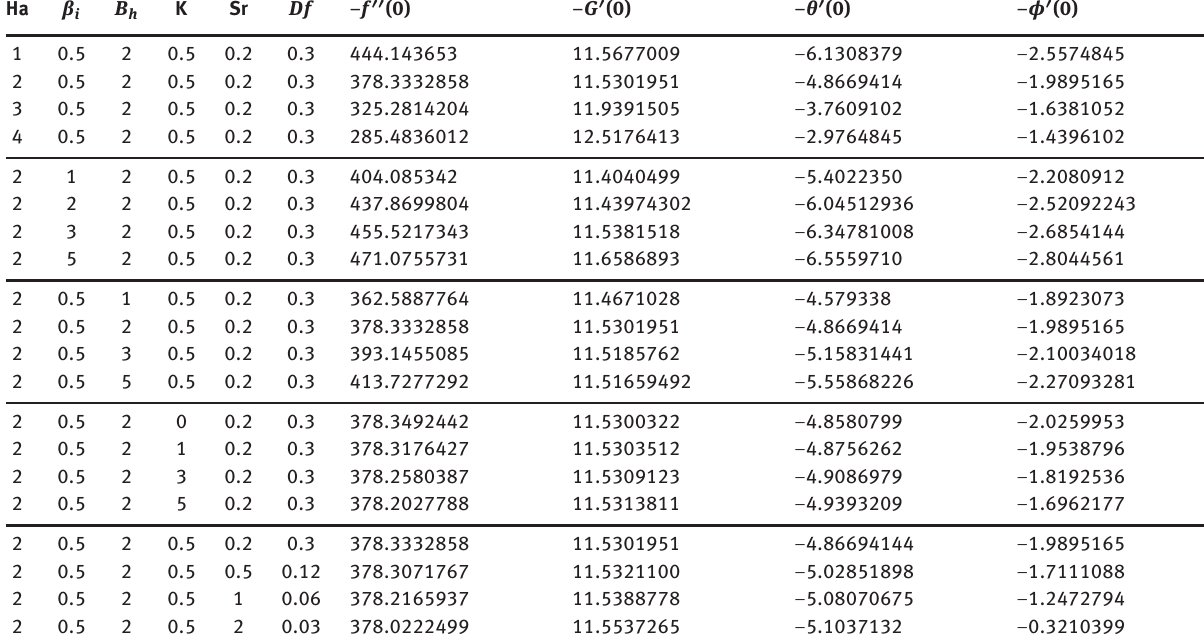
Table 2: Effects of tangential skin friction G (cid:2) (0) , radial skin friction f (cid:2)(cid:2) (0) heat transfer Nu and mass transfer Sh coefficients for varying values of Hartman number, ion-slip parameter, Hall parameter, chemical reaction parameter, Soret and dufour numbers with Re = 500